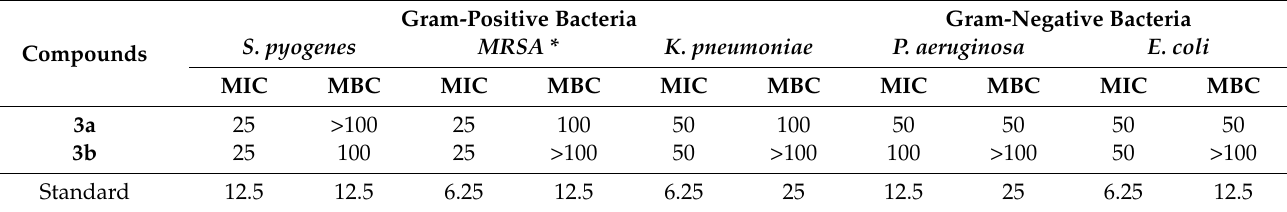
Table 8. MIC and MBC results of compounds 3a–b and positive control